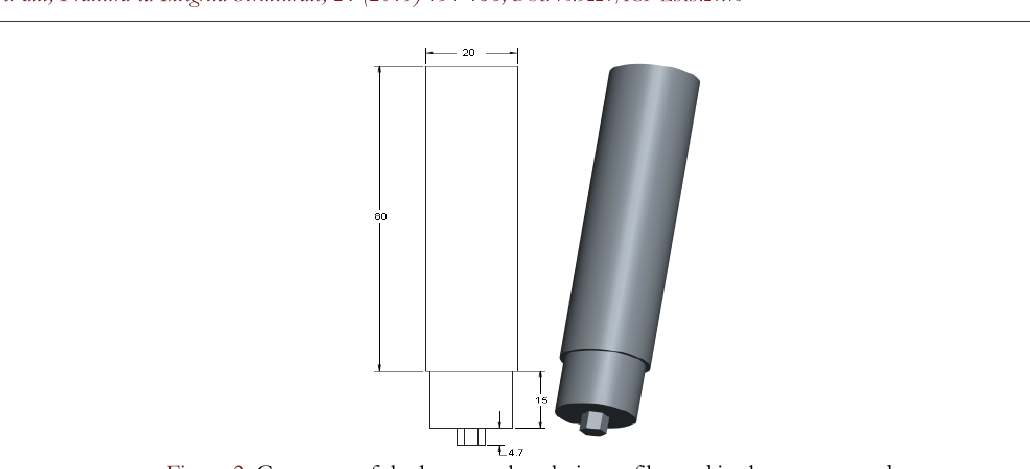
Figure 2: Geometry of the hexagonal tool pin profile used in the present study.